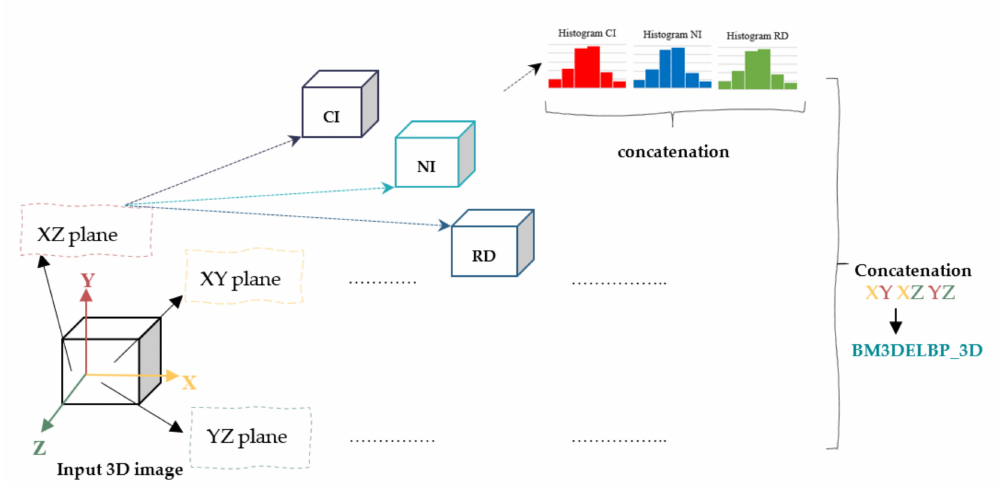
Figure 4. Block scheme of the 3D version of BM3DELBP for a single scale (© [2020] IEEE. Reprinted [adapted], with permission, from